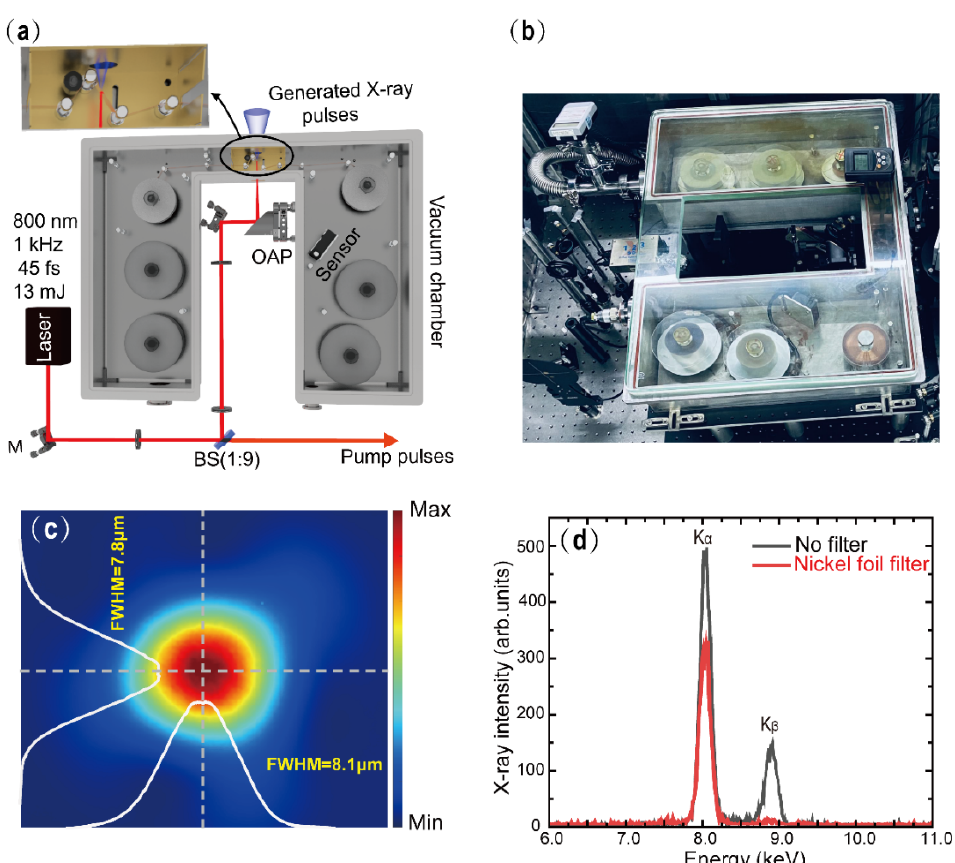
Figure 1. ( a ) Schematic diagram of the table-top laser-plasma-based X-ray source. ( b ) Top view of the X-ray generation vacuum chamber. ( c ) Image of the laser focal spot. The white lines show that the Full-With Half-Maximum (FWHM) values in the vertical and horizontal are 7.8 and 8.1 µ m, respectively. ( d ) The X-ray pulse spectrum. The black and red lines represent the spectrum without and with an 8 µ m nickel foil